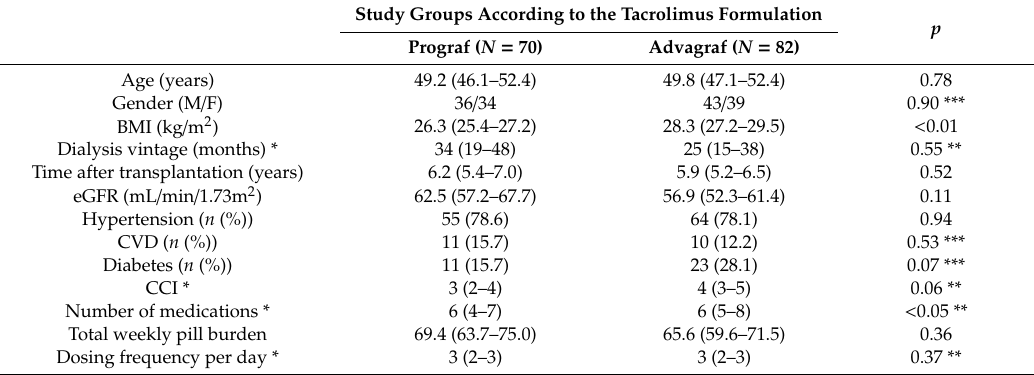
Table 2. Clinical characteristics of patients divided into the study groups according to the twice daily or once daily prescribed tacrolimus